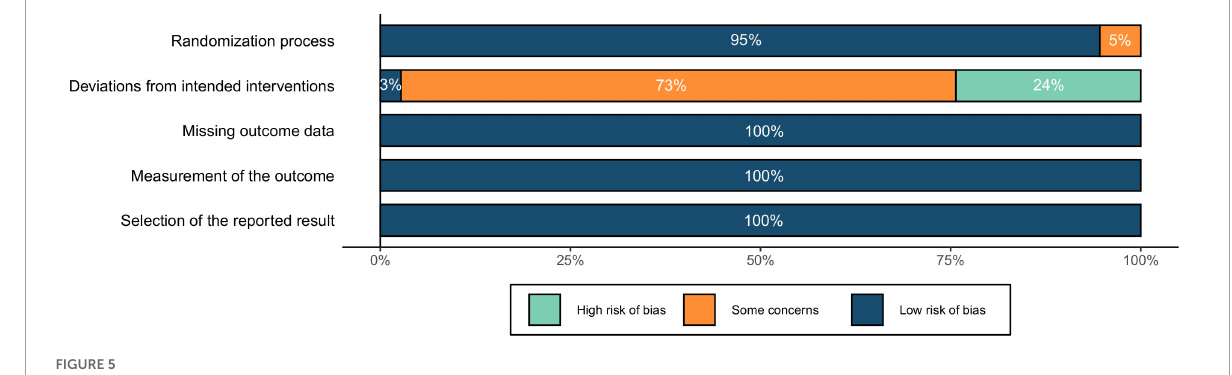
FIGURE5 Assessment of risk of bias for included studies.